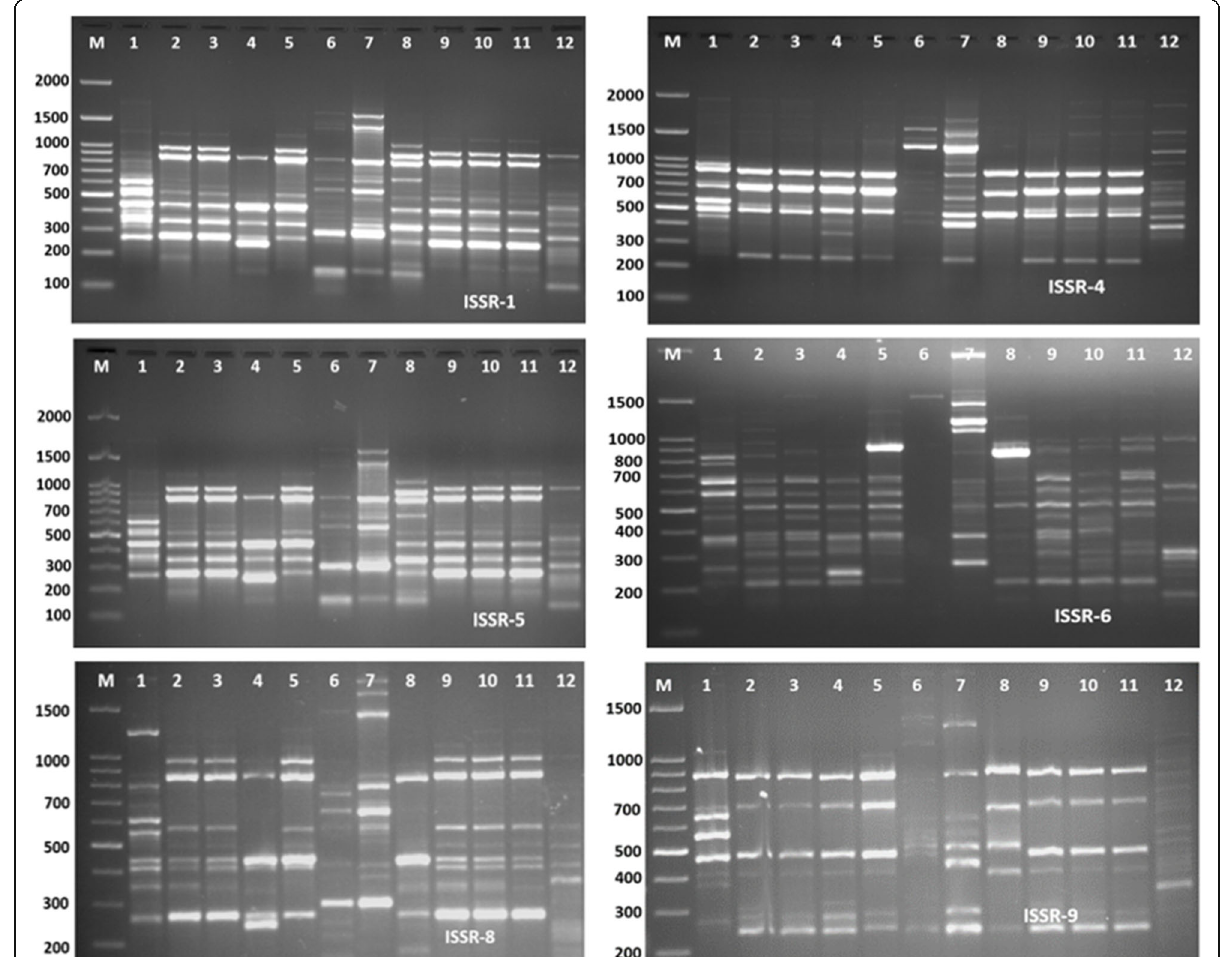
Fig. 2 ISSR-PCR profile of the 12 Trichoderma isolates generated with 6 ISSR primers. M is 100 bp DNA